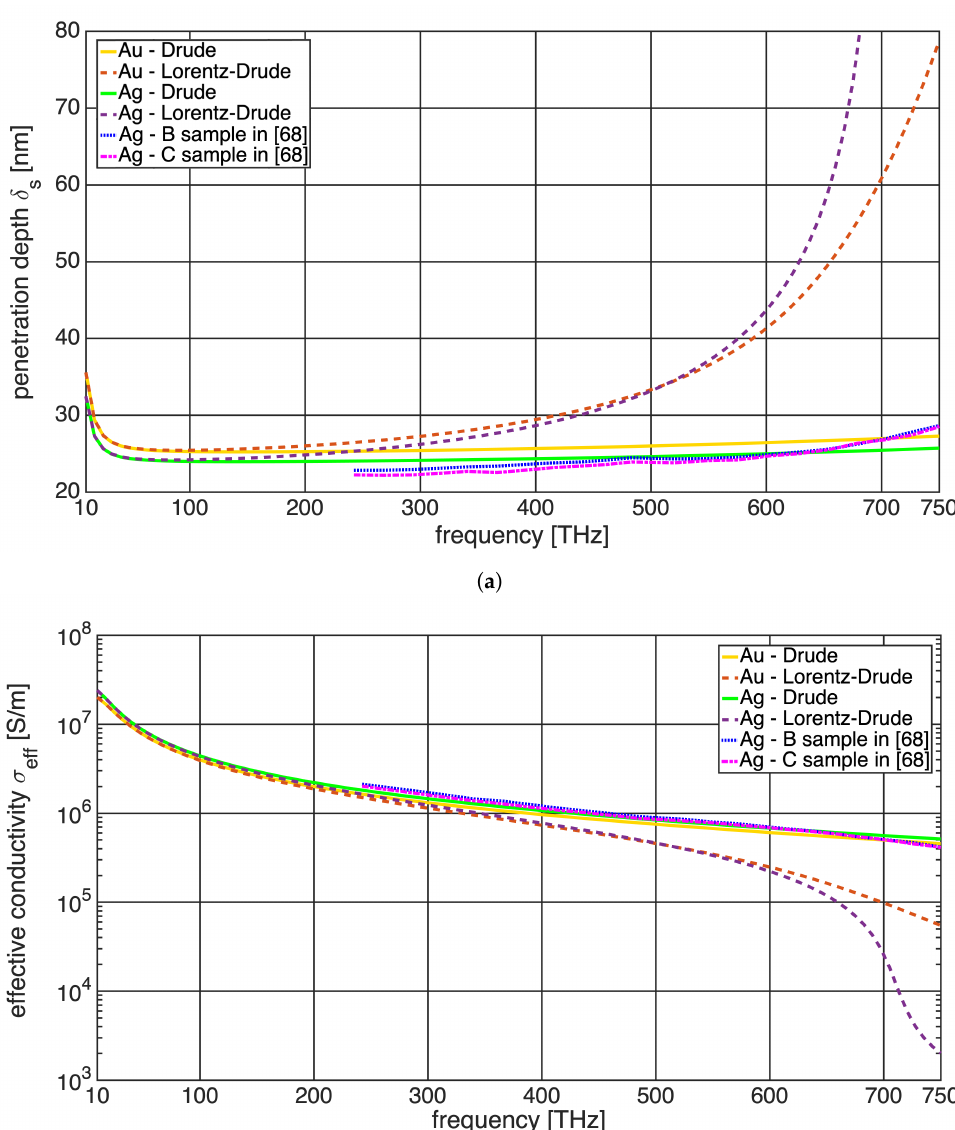
Figure 6. ( a ) Penetration depth δ s in nm and ( b ) effective conductivity (3) for the cases of Ag, and Au at 10–750 THz frequency range, using Drude and Lorentz–Drude models, as well as the measurements of two silver samples from Yang et al.